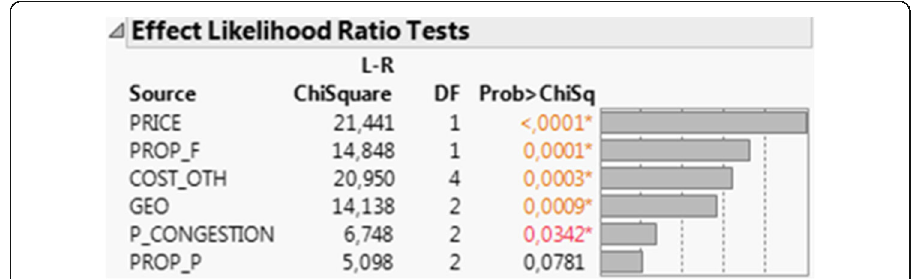
Fig. 3 Choice model parameter estimates and effect likelihood. Source: own